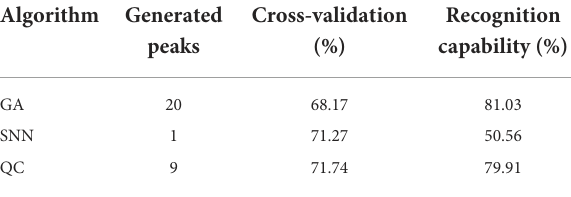
TABLE 3 Cross-validation and recognition capability calculated for each generated model in order to determine a common signature among spectra of group H and group